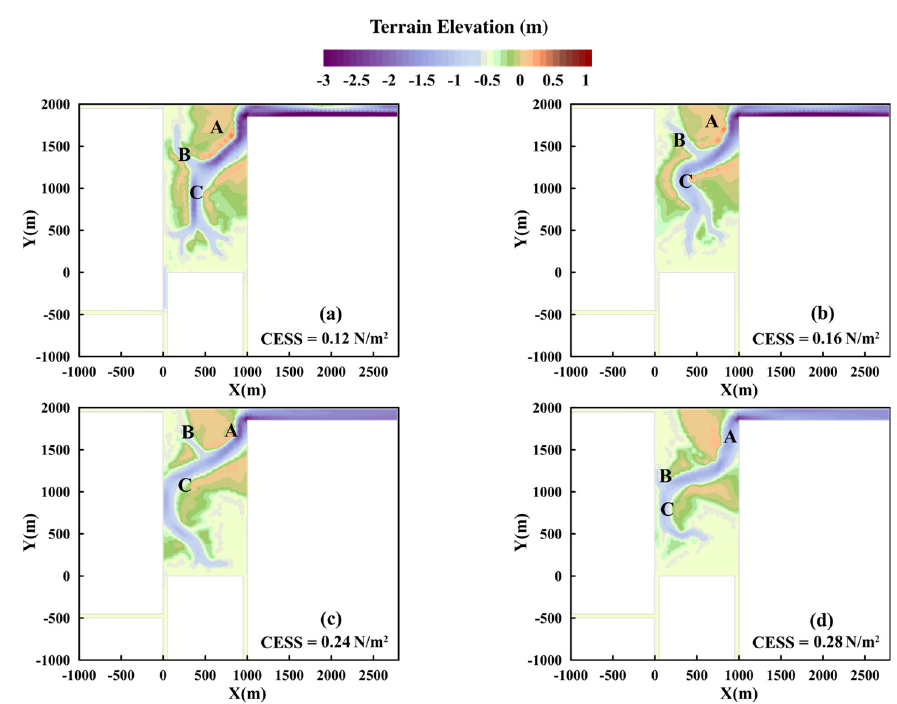
Figure 8. Terrain patterns of the ideal model of Qilihai Lagoon system for under different CESSs, after 100 years, where the CESS is ( a ) 0.12 N/m 2 , ( b ) 0.16 N/m 2 , ( c ) 0.24 N/m 2 and ( d ) 0.28 N/m 2 .